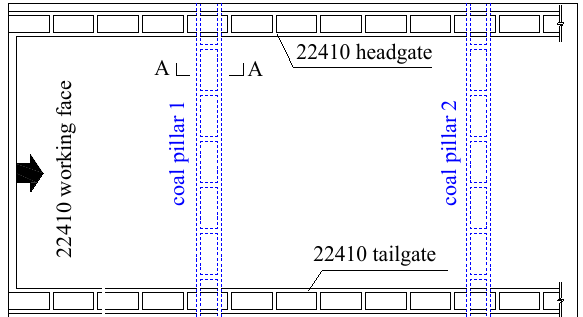
Figure 1. Plan view of the 22410 working face.